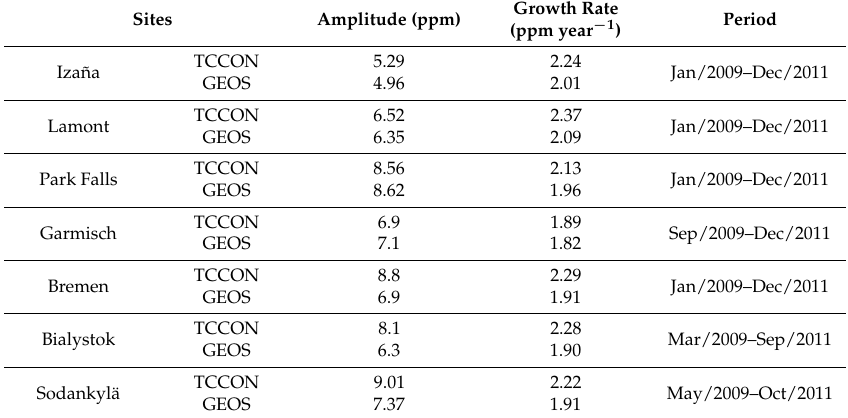
Table 4. Comparison of the seasonal cycle amplitude and yearly growth rate between XCO 2 of GEOS-Chem and TCCON sites. Sites included Izaña, Lamont, Park Falls, Garmisch, Bremen, Bialystok, and Sodankylä.